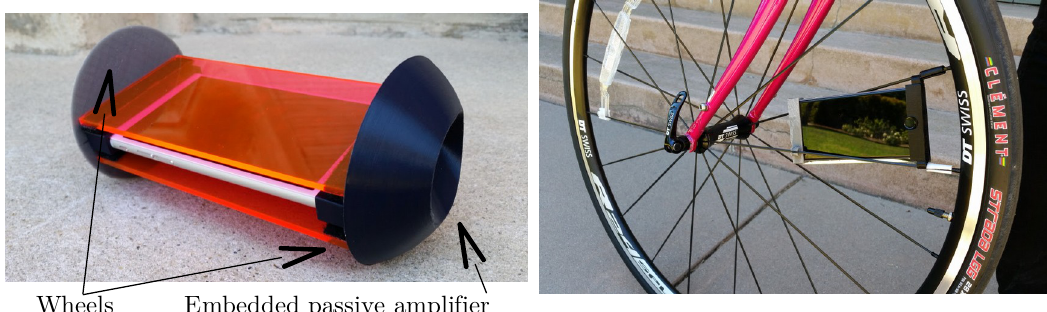
Figure 8. Rolling mobile phone with phasing effect by Revital Hollander ( on the left ) and mobile Wheels Embedded passive amplifier device mounted on a bike wheel by Patricia Robinson ( on the right